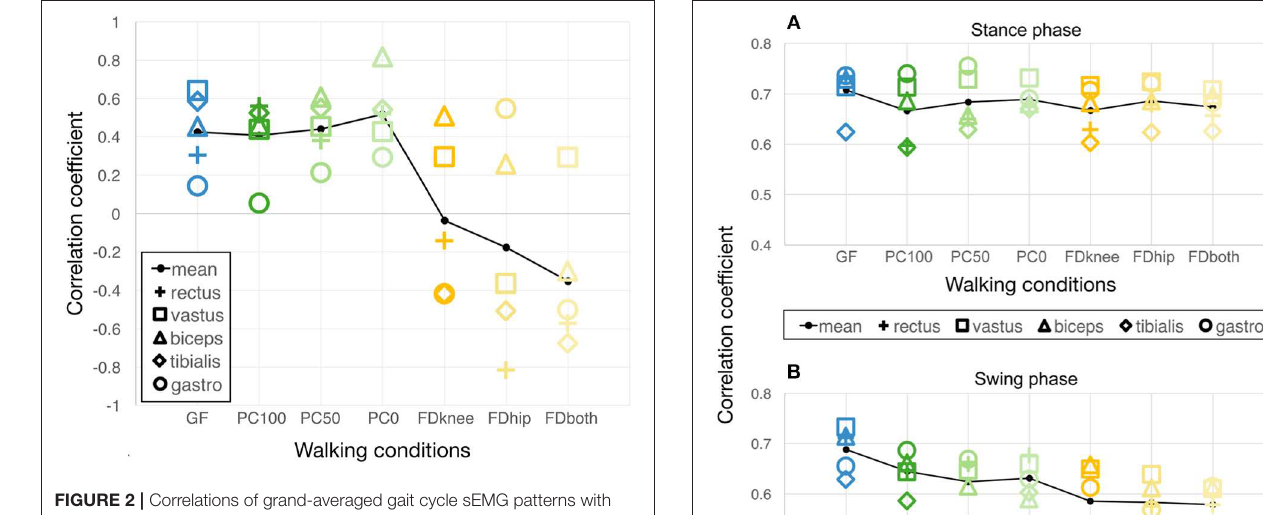
FIGURE 2 | Correlations of grand-averaged gait cycle sEMG patterns with norm patterns. For each condition, the sEMG pattern of the grand-averaged gait cycle of each measured muscle was correlated with the respective norm pattern from Chang et al. (2007). Higher values accordingly denote a more similar muscle activity pattern compared to that of healthy children walking overground. The black line connects the average values of all correlations of the five measured muscles. GF, Guidance Force; PC, Path Control; FD, FreeD; PC100 (and PC50 and PC0, respectively), Path Control with support force 100% (and 50 and 0%, respectively); FDknee, cuffs laterally moveable, pelvis fixated; FDhip, active pelvic translation/rotation, cuffs fixated; FDboth, cuffs laterally moveable and active pelvic translation/rotation; rectus, M. rectus femoris; vastus, M. vastus medialis; biceps, M. biceps femoris; tibialis, M. tibialis anterior; gastro M. gastrocnemius lateralis.